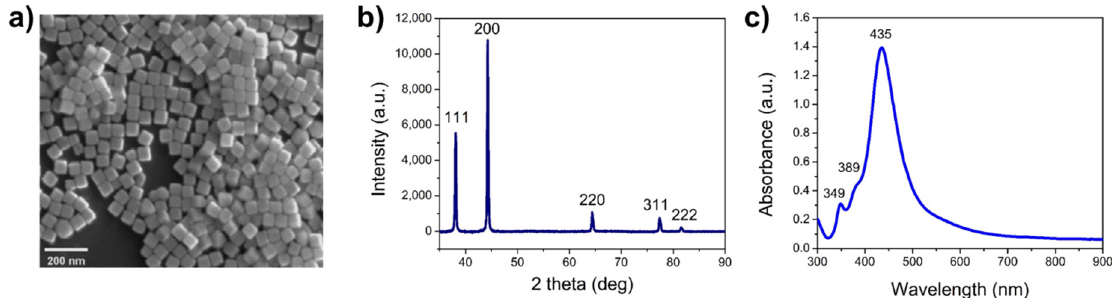
Figure 1. Characterization of synthesized AgNCs using ( a ) SEM, ( b ) XRD, and ( c ) UV-Vis spectrum.